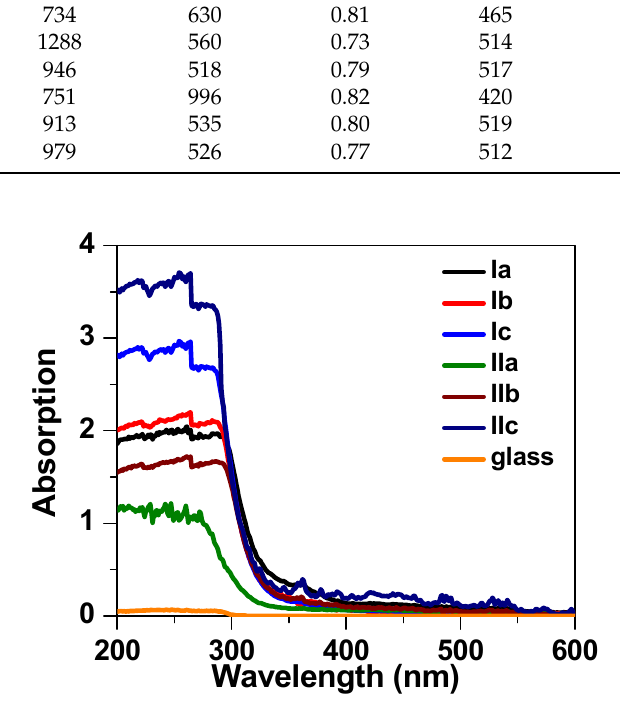
Table 2. Optical bandgap and fitting parameters of decay spectra for series Ia-c and IIa-c . Films